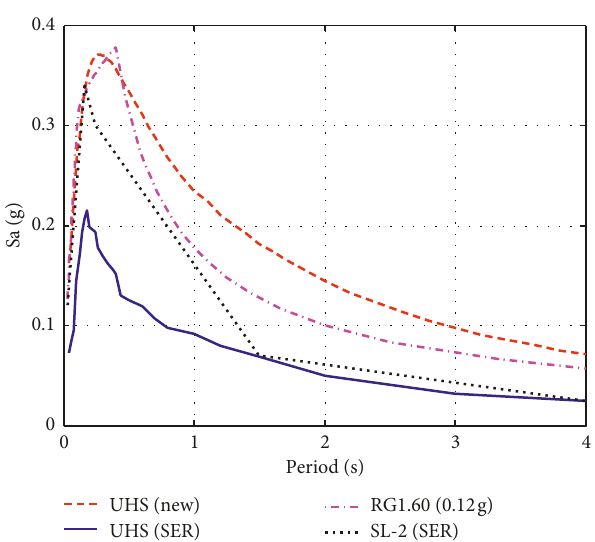
Figure 10: Comparison of the new UHS with other spectra.